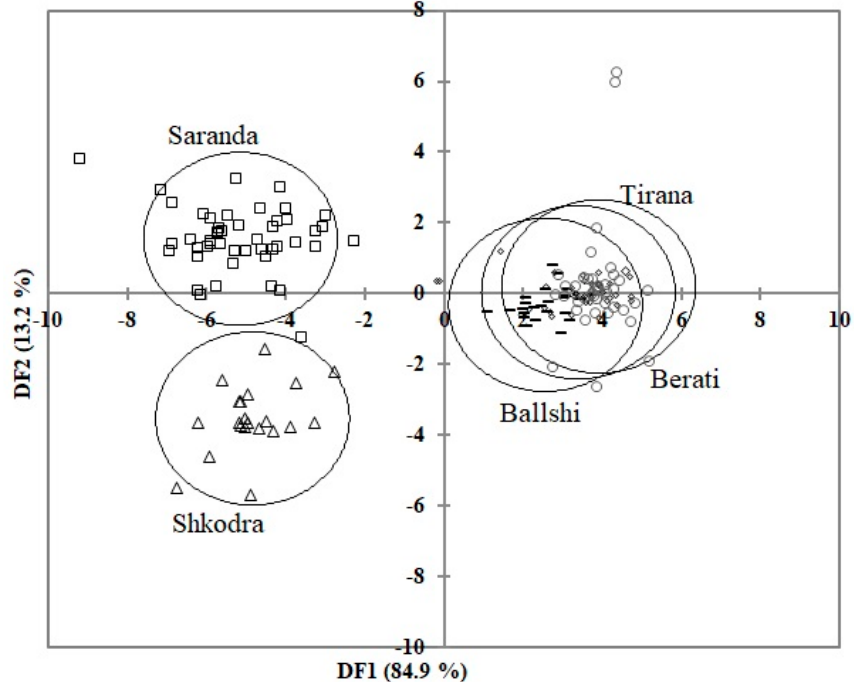
Figure 4. Discriminant function analysis plot with 95% confidence ellipses based on morphological analysis among the five regions in Albania.